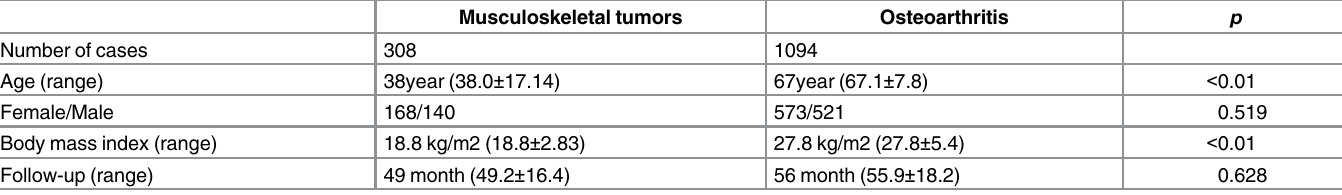
Table 1. Demographics of two